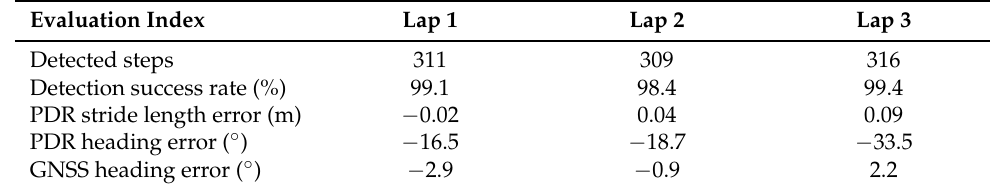
Figure 5. Results of control point test. ( a ) PDR stride length estimation. ( b ) PDR heading estimation. ( c ) GNSS heading estimation. Table 1. Results of three-lap control point test for two standalone